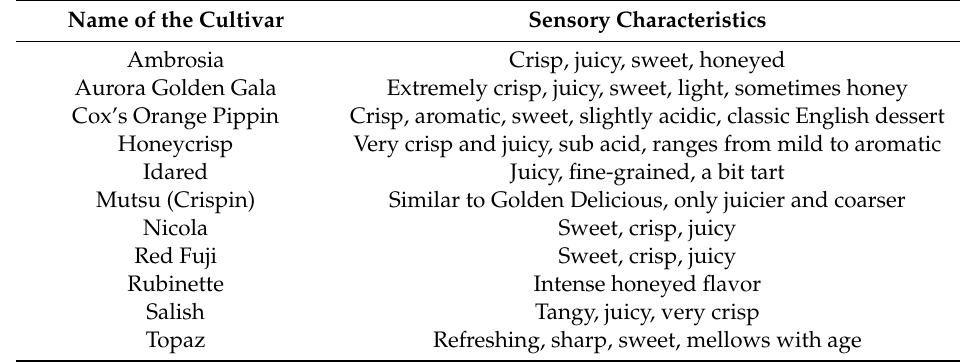
Table 1. Information presented by the Friends of Garden (FOGs) at the University of British Columbia (UBC) Apple Festival for the cultivars purchased frequently at the special-event market. Name of the Cultivar Sensory Characteristics Ambrosia Crisp, juicy, sweet, honeyed Aurora Golden Gala Extremely crisp, juicy, sweet, light, sometimes honey Cox’s Orange Pippin Crisp, aromatic, sweet, slightly acidic, classic English dessert Honeycrisp Very crisp and juicy, sub acid, ranges from mild to aromatic Idared Juicy, fine-grained, a bit tart Mutsu (Crispin) Similar to Golden Delicious, only juicier and coarser Nicola Sweet, crisp, juicy Red Fuji Sweet, crisp, juicy Rubinette Intense honeyed flavor Salish